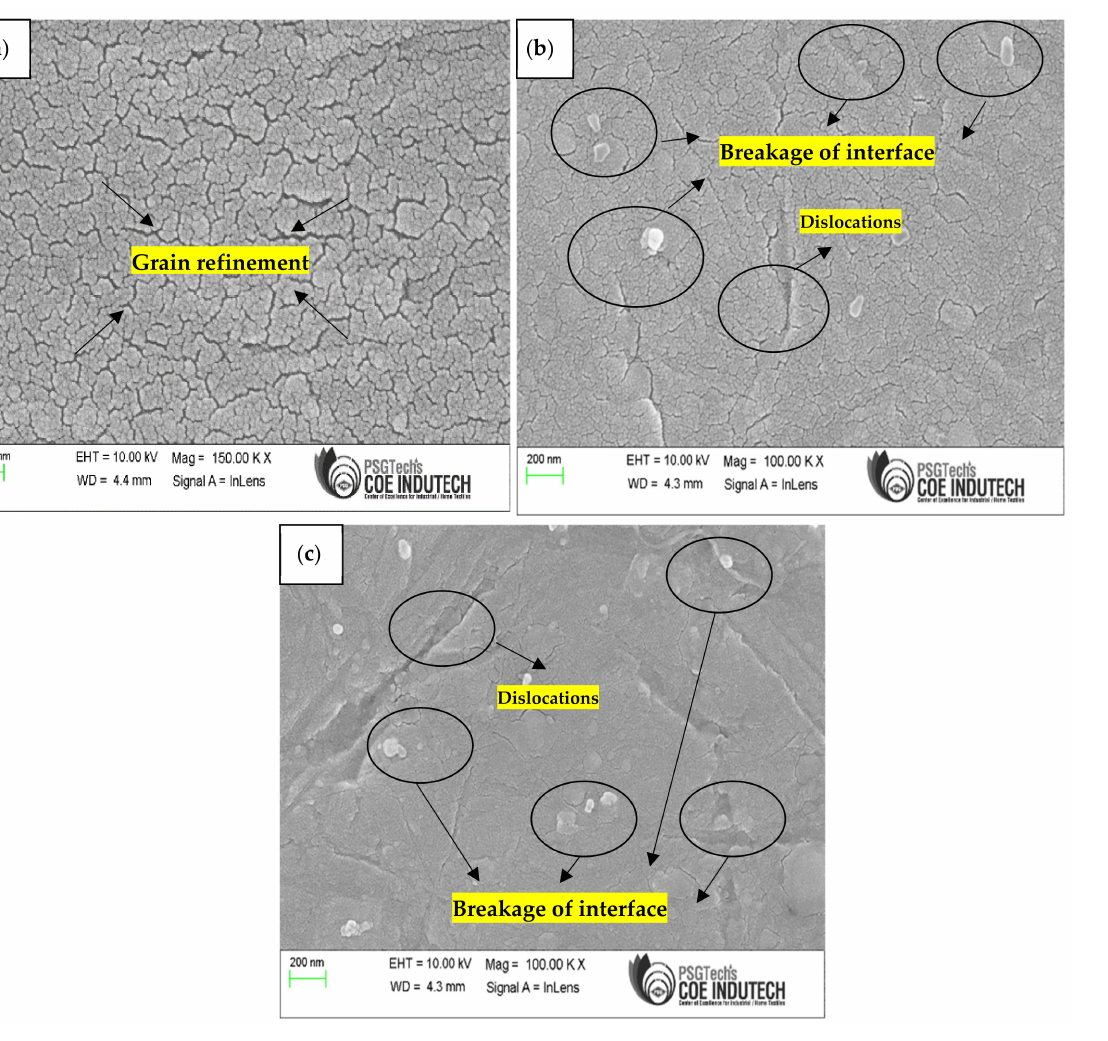
Figure 8. FE–SEM image of the shock wave exposed: ( a ) AA5083; ( b ) 1 wt.% of Al 2 SiO 5 -reinforced composite materials; ( c ) 2 wt.% of Al 2 SiO 5 -reinforced composite